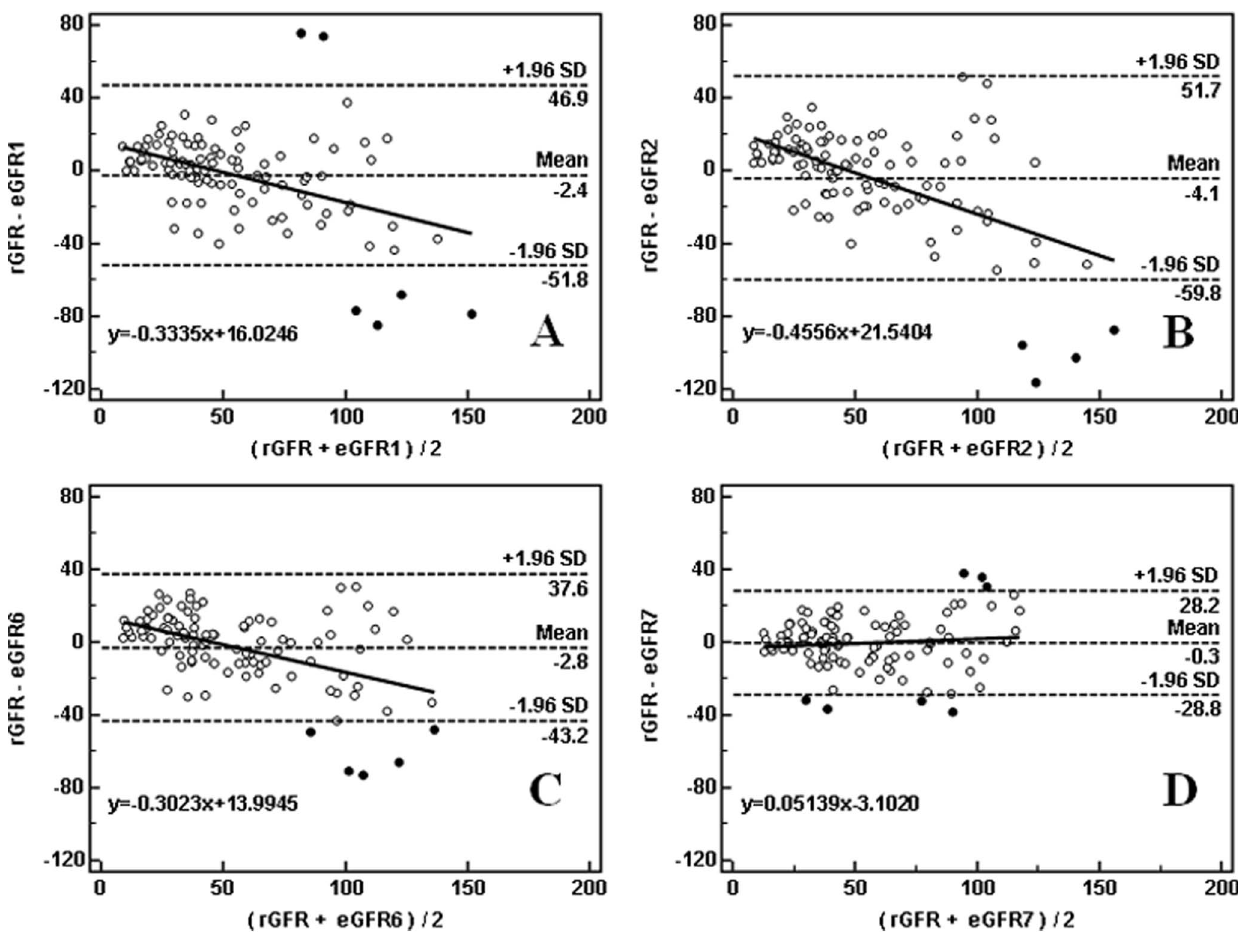
Figure 2. Altman-Bland plot: comparison between eGFR and rGFR (n=101).